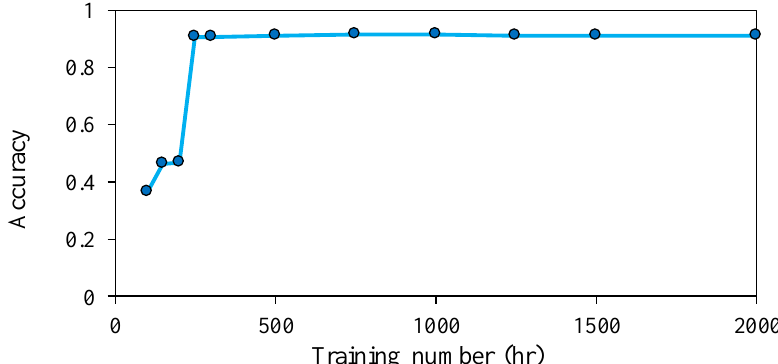
Figure 5. Simulation accuracy of the random forest model with various training numbers in our study. The accuracy was calculated by dividing the correct number of random forest model into the total number of trainings. The accuracy exceeded 0.9 with more than 250 training numbers.